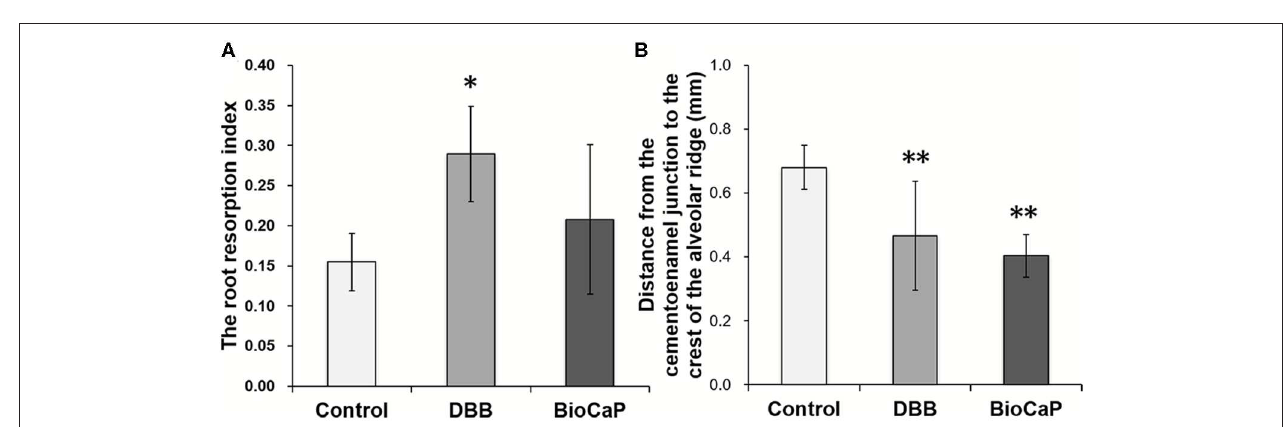
FIGURE 5 | Bio-CaP didn’t affect the dental root resorption and maintained the distance from the enamel cementum to the crest of the alveolar ridge. (A) The root resorption index at week 8. (B) The distance from the enamel cementum to the crest of the alveolar ridge at week 8. Data are presented as mean ± SD, from six independent experiments. Significant effect of the treatment, * p < 0.05, and ** p < 0.01.